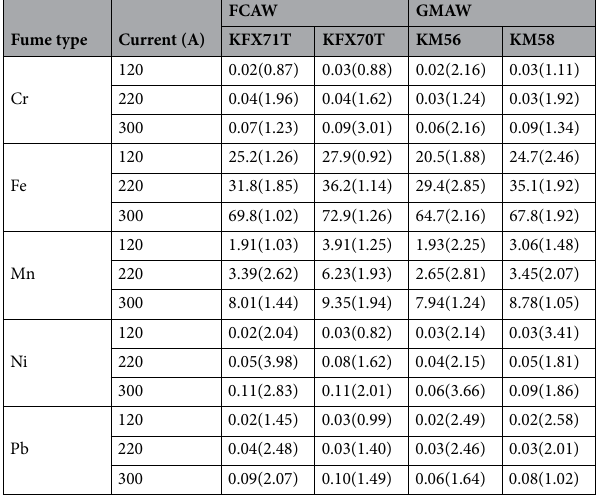
Table 1. The emission rates (ER) (mg/min) (CV) of welding metal fume for the selected welding